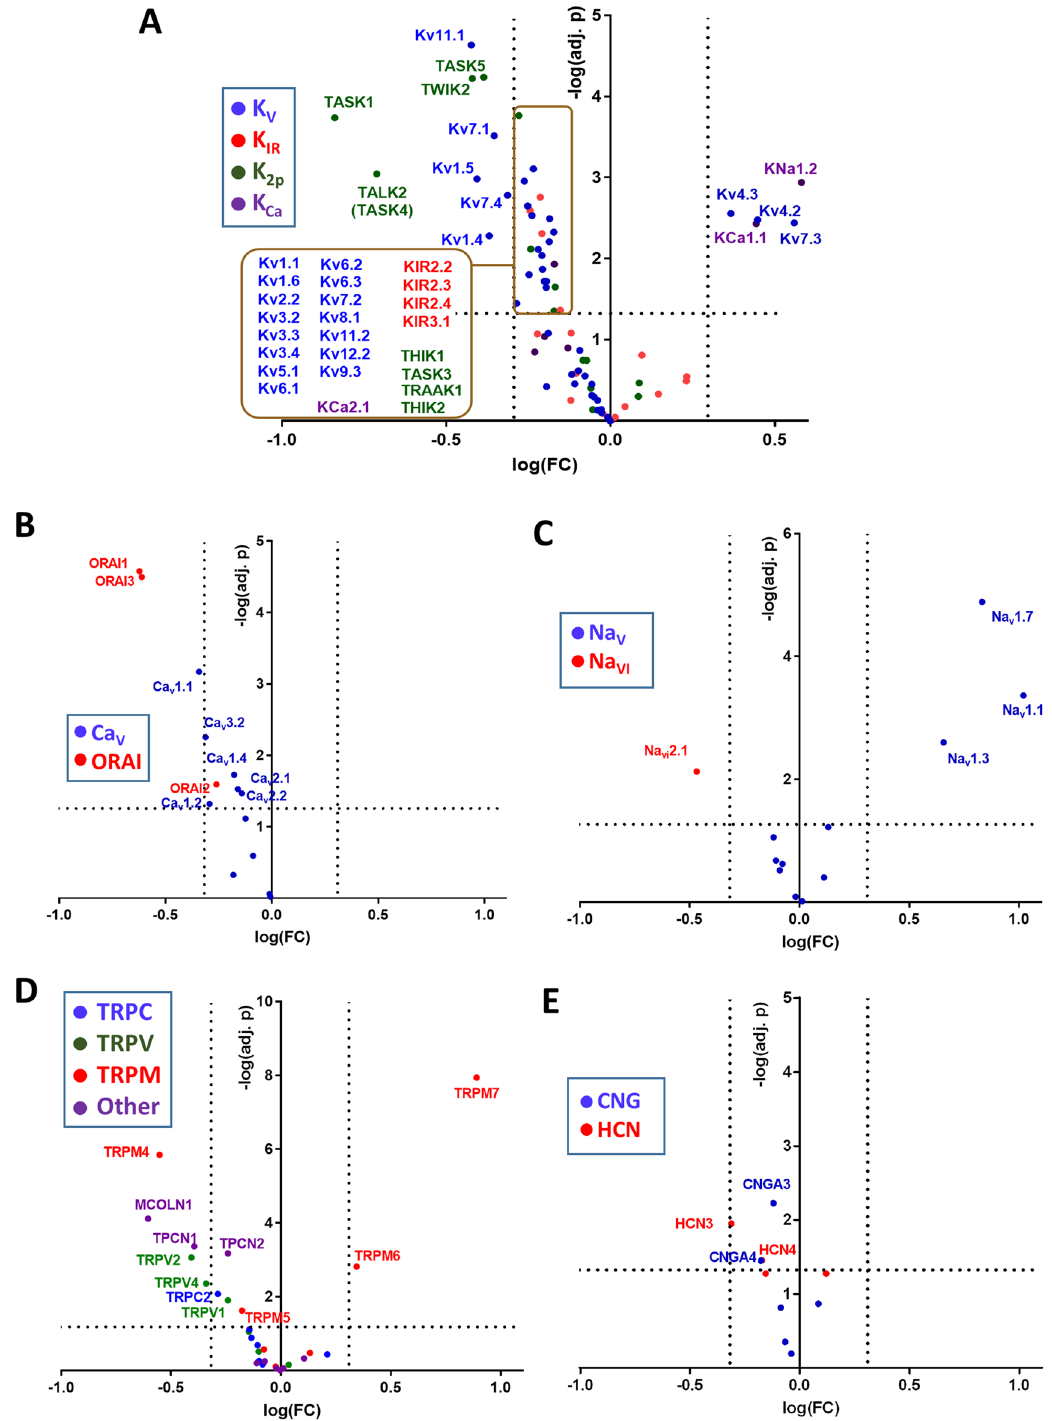
Figure 4. Vulcano plot [log fold change against − log (adjusted p value)] showing the changes in mRNA transcripts for cationic channel encoding genes ( A ) K + , B) Ca 2+ , C) Na + , D) TRP and E) CNG/HCN superfamilies. The vertical lines correspond to twofold up and down, respectively, and dots above the horizontal dotted line indicate adjusted p <